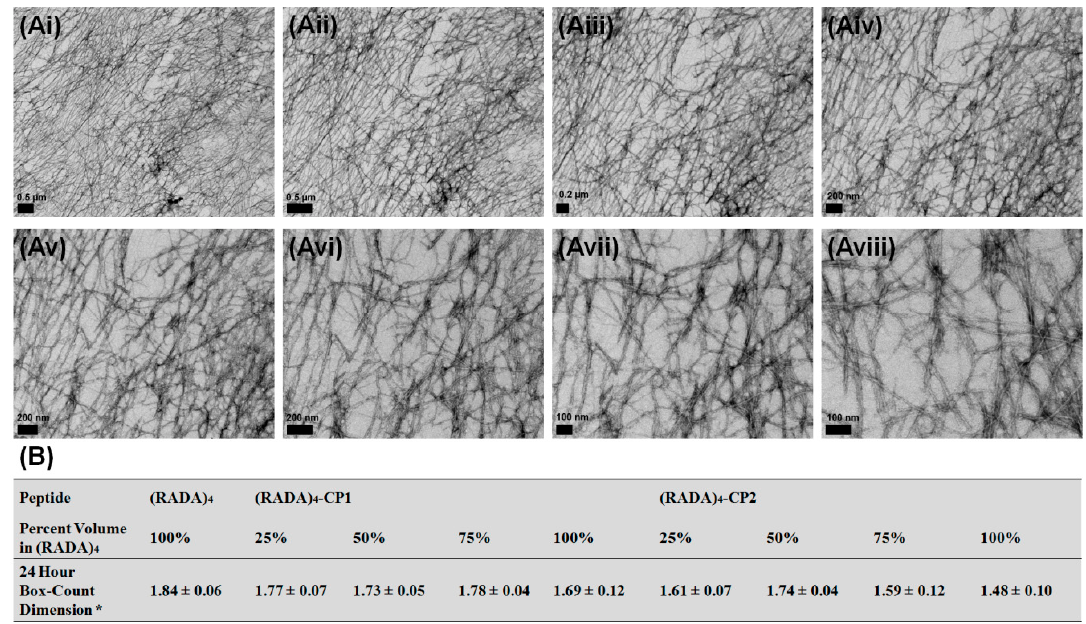
Figure 7. Transmission electron microscopy of ( Ai – viii ) various magnifications and ( B ) average Hausdorff box ‐ count dimensions over 10 incremental changes in magnification (1400, 1800, 22,000, 28,000, 36,000, 44,000, 56,000, 71,000, 89,000, and 110,000× magnification). All samples were stained with 4% uranyl acetate and imaged at 0.5% w/v in TNC buffer upon 30 min of sonication and 24 h of incubation at 37 °C. Scale bars are all 100 nm, data analyzed represents mean ± SD over the magnifications and n = 3 experimental repeats.